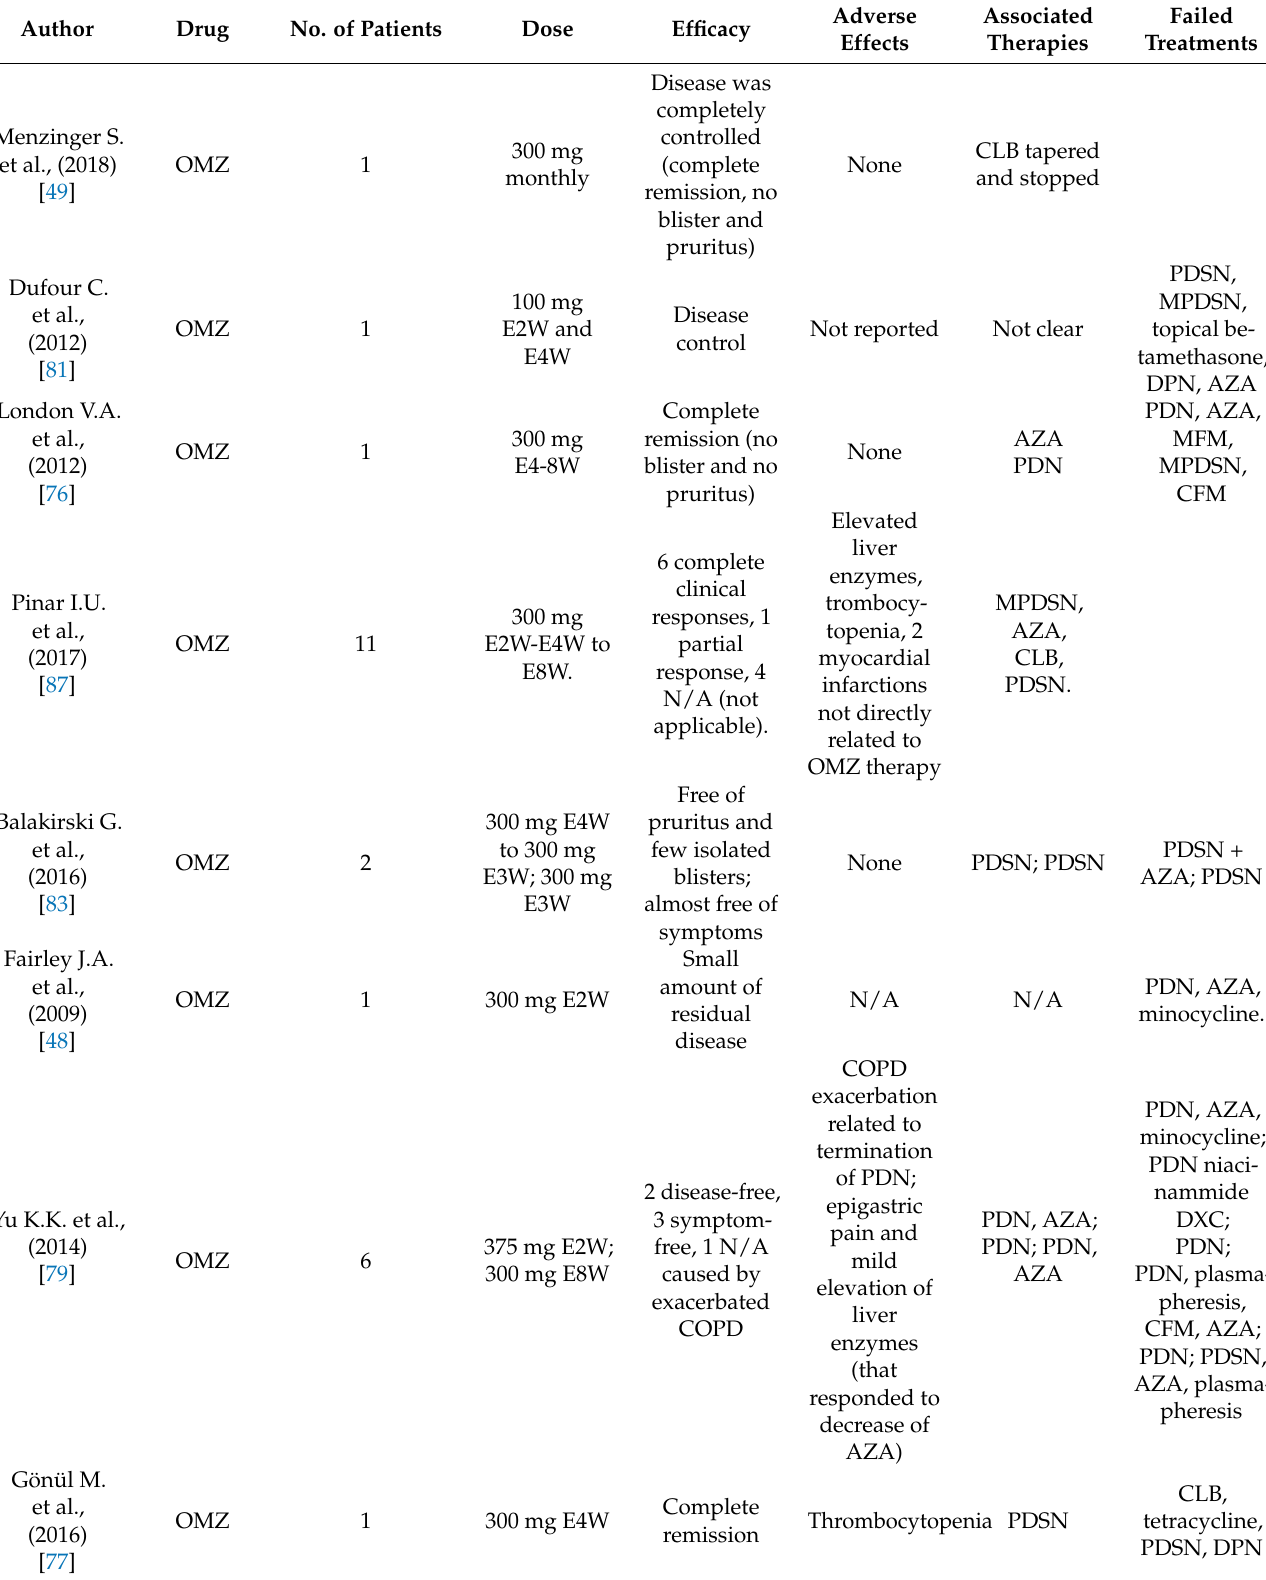
Table 3. Studies summarizing omalizumab use in